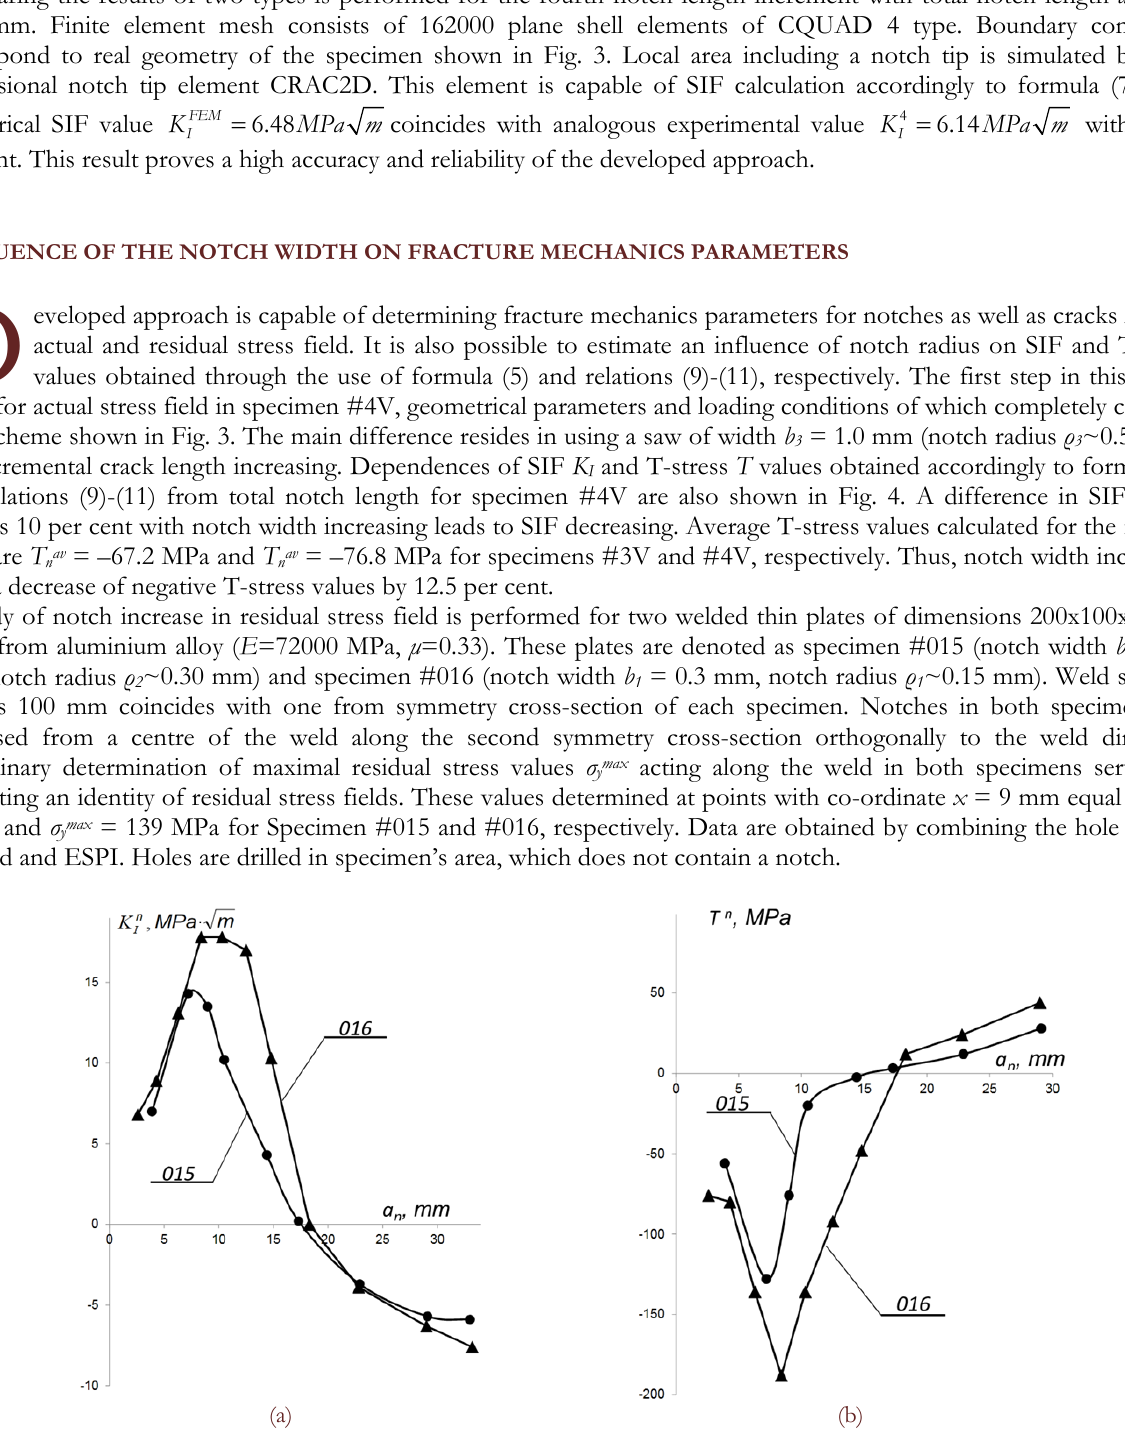
Figure 5: Dependences of SIF K